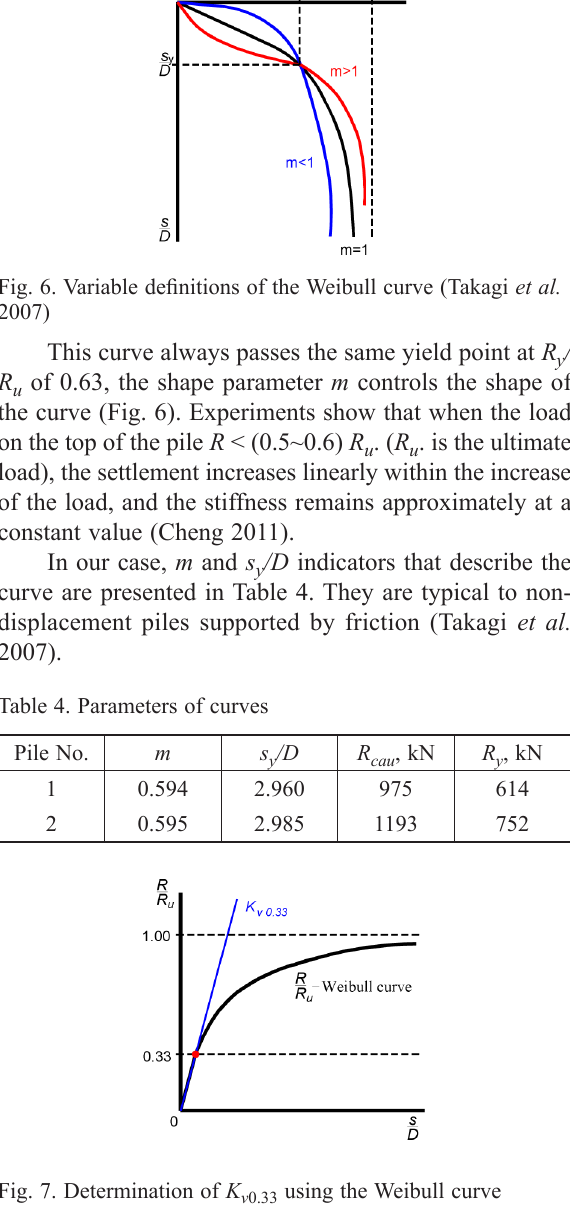
Fig. 7. Determination of K v 0.33 using the Weibull curve